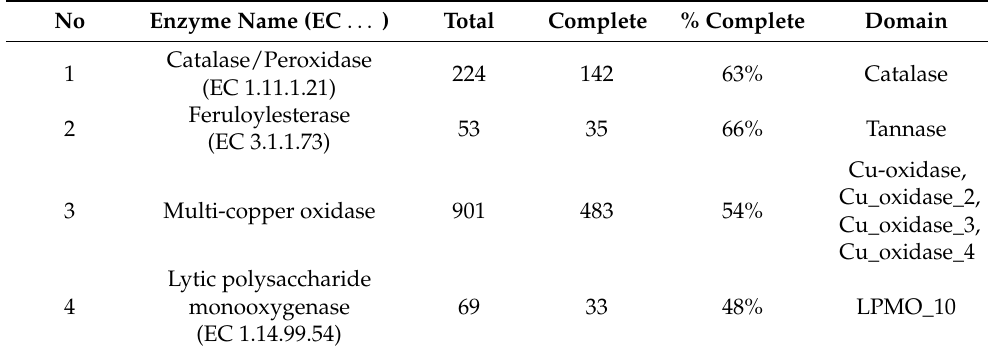
Table 5. Summary of ORFs encoding pretreatment enzymes mined from the humus metagenomics DNA using profile